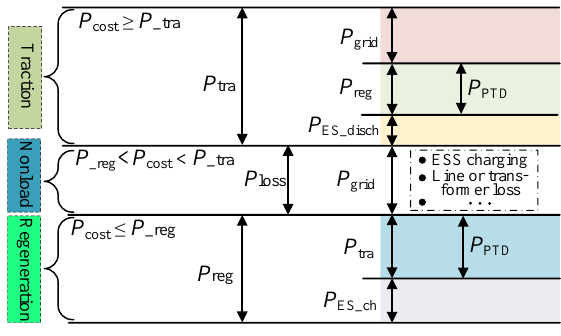
Figure 5. Energy distribution of the whole railway system.